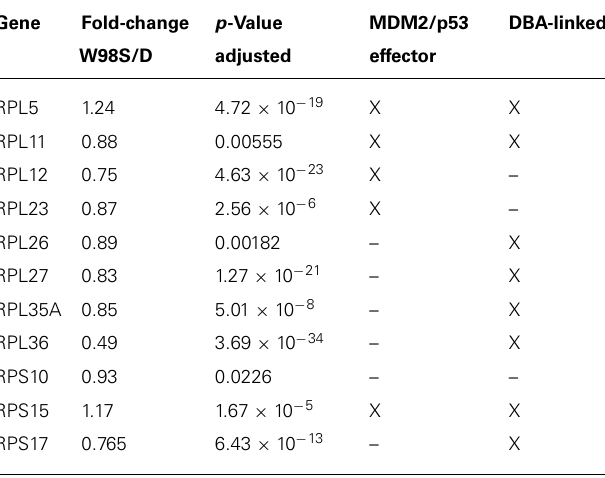
Table 2 | Differentially expressed RPs linked with human